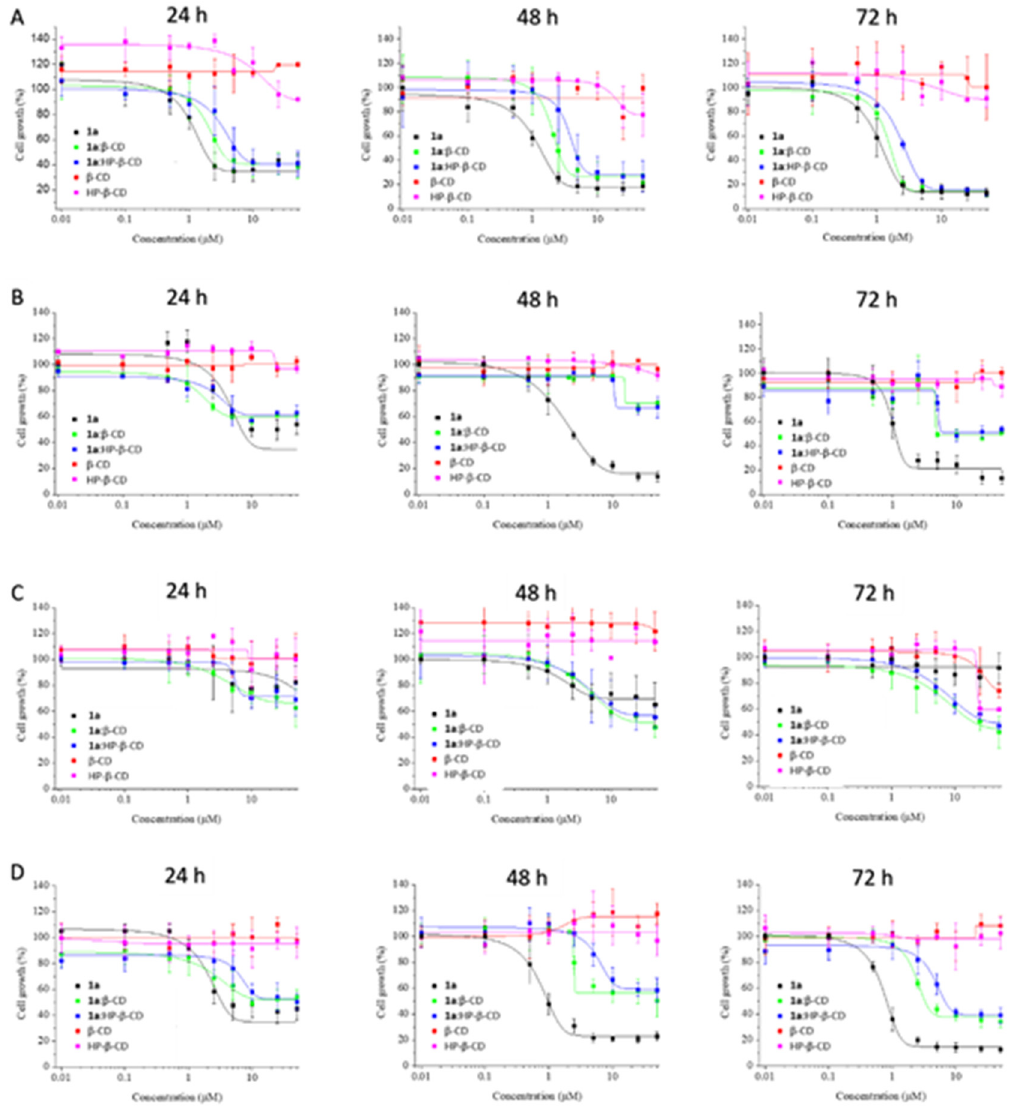
Figure 10. Dose-response curves obtained for 1a (black lines), β -CD (red lines) and HP- β -CD (pink lines), as well as the formulations 1a : β -CD (green lines) and 1a :HP- β -CD (blue lines) on HT-29 ( A ), HCT-116 ( B ), RKO ( C ) and Caco-2 ( D ) cell lines at 24, 48 and 72 h.